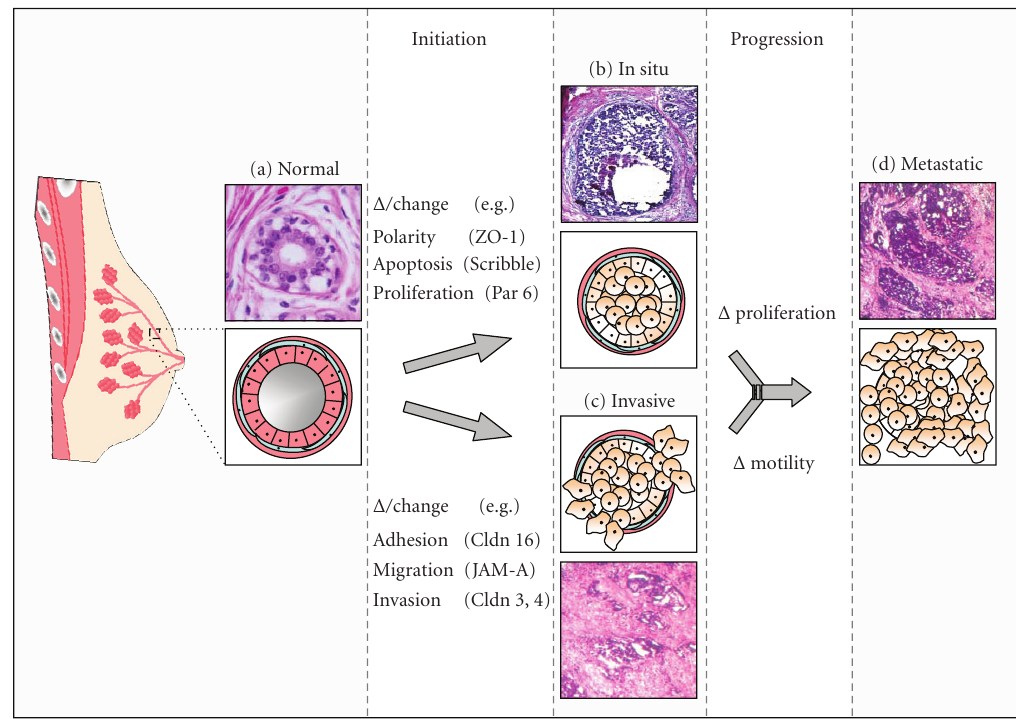
Figure 2: The potential influence of TJ proteins on breast cancer development. Breast cancer predominantly begins in luminal epithelial cells lining the normal breast ducts (a). Alterations in TJ proteins may lead to the initiation of breast tumourigenesis in at least two ways. Firstly, TJ alterations may favour decreased cellular apoptosis and increased proliferation leading to uncontrolled growth, such as is seen in ductal carcinoma in situ lesions (b). Secondly, TJ alterations may decrease cell adhesion and increase motility, facilitating cancer cell migration as seen during invasion and basement membrane breakdown in early primary invasive breast carcinoma (c). Breast carcinoma likely requires coordinated e ff orts of both increased proliferation and increased motility to progress to metastatic stages